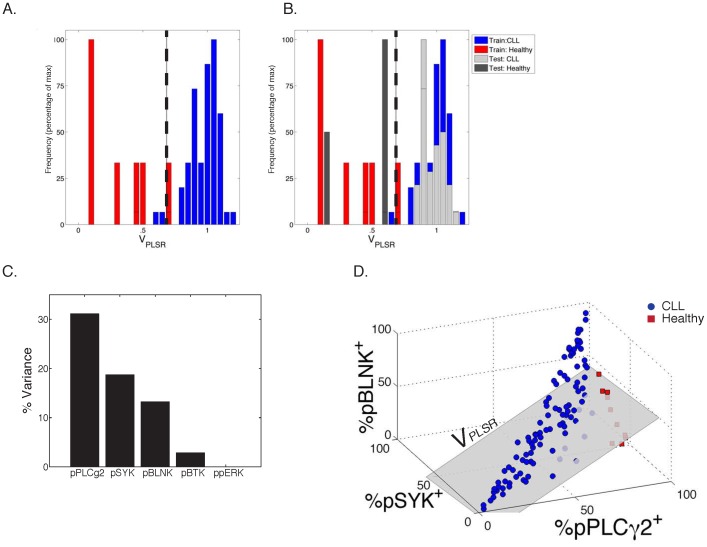
PLSR Model Results.A Distributions of VPLSR scores for CLL and healthy samples from the training cohort. The x-axis shows the range of VPLSR solutions, with healthy individuals significantly clustering on the lower extreme, and CLL patients' phosphoprofiles producing high VPLSR scores (p<0.0001). This plot shows only patients included in the training set. The vertical black line at VPLSR = 0.695 represents the optimized cutoff between CLL and healthy phosphoprofiles (see Supp. Fig. S7). B Distribution of VPLSR scores for CLL and healthy samples from the training set (light and dark grey bars), overlaid to the VPLSR distribution of the training set. The model is upheld as the test set data is correctly partitioned by disease status (p<0.0001). Root mean squared error (RMSE) measurements quantify the regression error, supporting the validity and applicability of the model to other datasets: RMSEtraining = 0.1750; RMSEtest = 0.1576; RMSEall = 0.1644. Training set: CLL = 67; Healthy = 7. Test set: CLL = 38; Healthy = 3. C Percent variance between the disease states, according to VPLSR weight. Each phosphor-epitope individually accounts for the indicated percentage of the variability between CLL samples and healthy samples within the PLSR model. As shown, pPLCγ2+ has the strongest power in distinguishing healthy from CLL. D 3D-representation of VPLSR: a compendium of phosphoresponses best discriminating between CLL and healthy individuals. Each samples is represented as a datapoint, positioned in space according to the value of %pX+, for each axis. The grey plane corresponds to VPLSR = 0.695, which best separates CLL from healthy individuals.